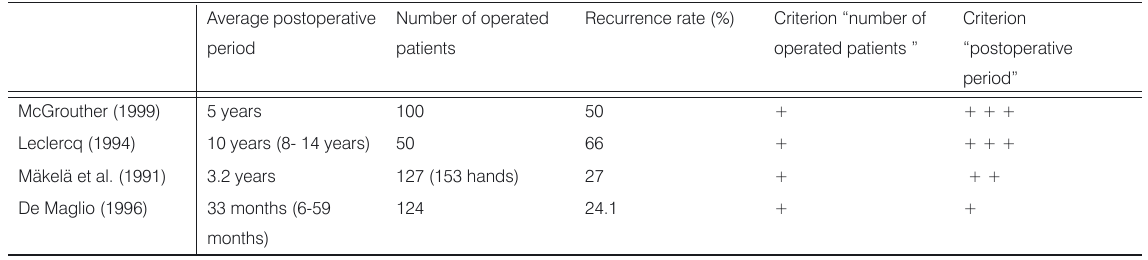
Table 5. Results after partial fasciectomy.